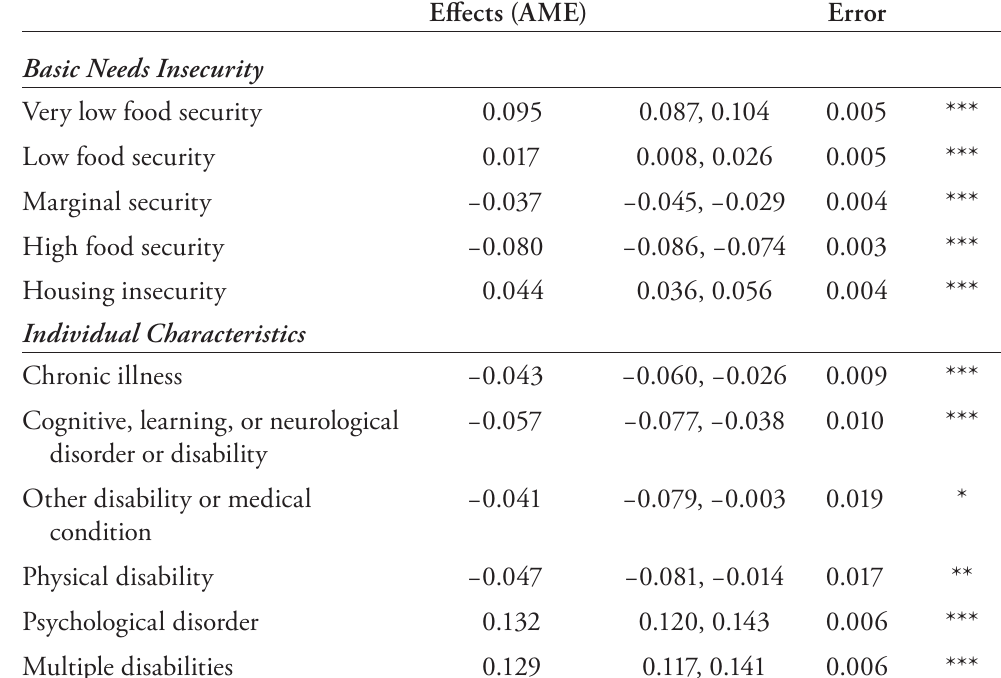
Table 2. Results of the Logistic Regression for Major Depressive Disorder